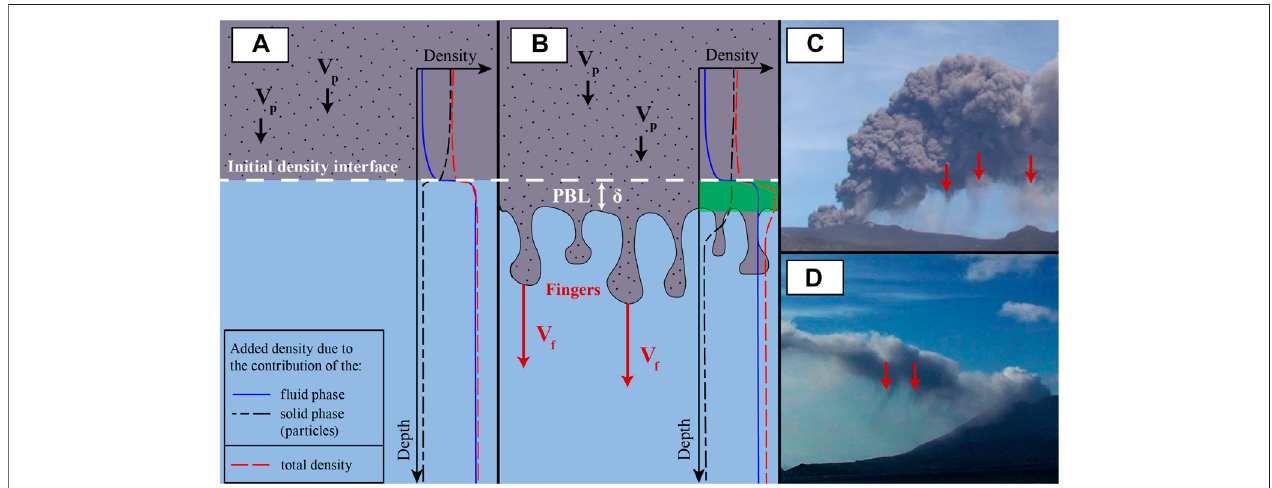
FIGURE 1 | Schematic representation of the mechanism by which settling-driven gravitational instabilities arise. (A) The particle suspension (gray) initially overlies particle-free fl uid (blue) and the density pro fi le is stable. (B) Particles settle at their individual fall velocity ( V p ) across the density interface between the particle suspension andtheunderlying,initiallydenserlower fl uid,formingadenseParticleBoundaryLayer(PBL)ofthickness δ ,highlightedingreen,thatcontainsdensitycontributionsfrom both thesolidand fl uidphases. Destabilizationofthedensity strati fi cation leadstotheformationof fi ngers thatrapidlydescend ataspeed V f > V p .Ash fi ngershave beenobservedatthebaseofvolcaniccloudsincluding (C) Eyjafjallajökull2010,Iceland(Manzellaetal.,2015),and (D) Sakurajima2019,Japan.Redarrowshighlightthe presenceof fi ngers.Notethatmorecomplexmechanismsthanpureindividualsettlingsuchaswind-drivenstirringcanalsoaffecttheparticledeliverytothePBLinthese natural examples and modify the density con fi guration that gives rise to ash fi ngers.